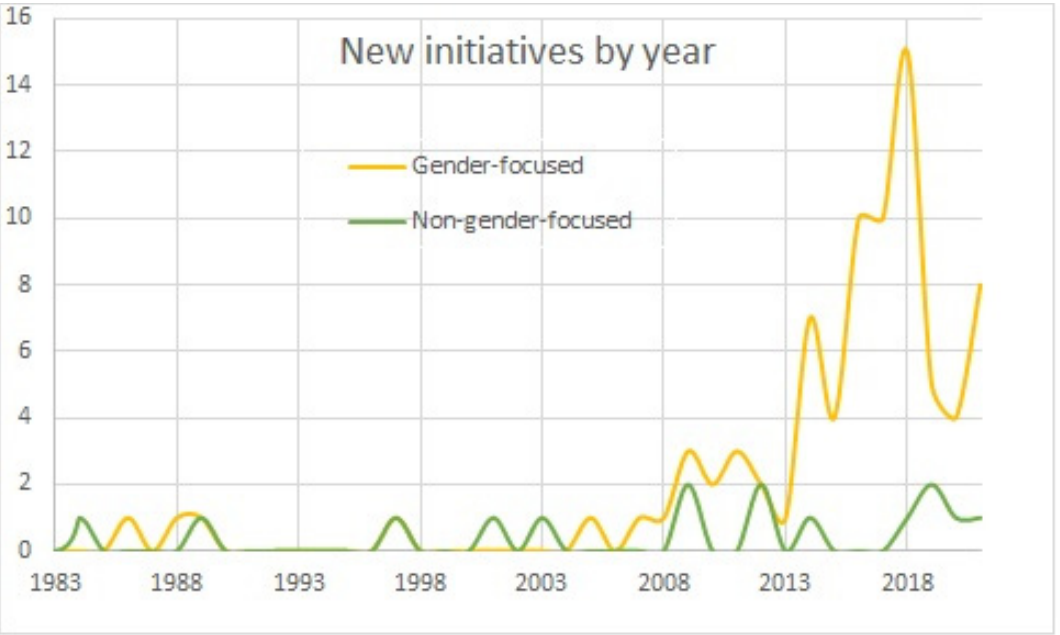
Figure 4. Gender-focused and non-gender-focused initiatives by founding year, since 1983. The graph excludes one gender-focused initiative founded in 1965 for viewability.